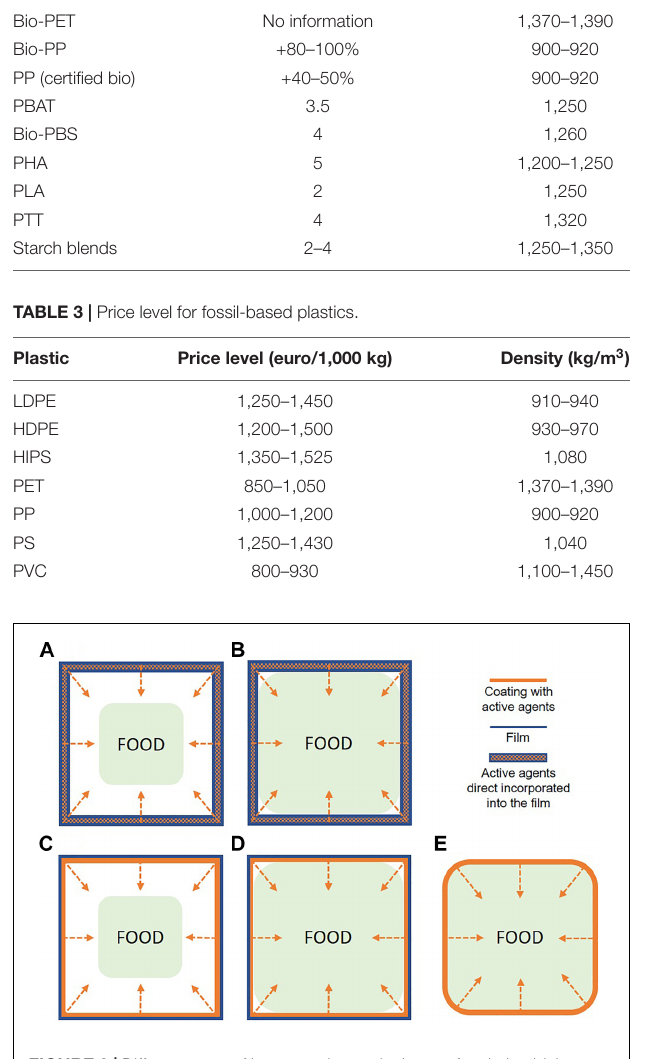
oils against E. coli, Staphylococcus aureus, Salmonella enteritidis, Listeria monocytogenes, and Lactobacillus plantarum . Oregano proved to be the most effective against bacteria, while rosemary showed no